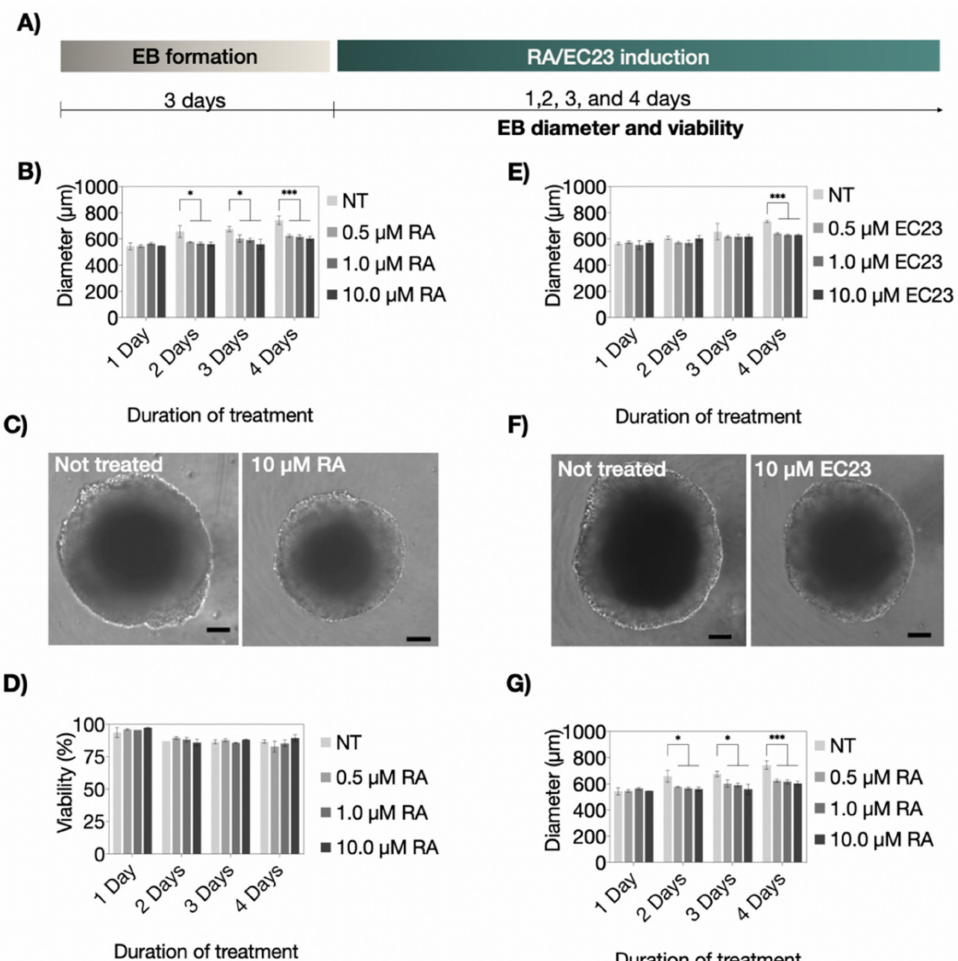
Figure 2. ( A ) Schematic workflow of neuronal and astrocytic differentiation protocols using retinoic acid (RA) or EC23 as inducers. Diameters of embryoid bodies after one-, two-, three- and four- day treatment with concentrations of non-treated (NT), 0.5 µ M, 1.0 µ M, and 10 µ M of ( B ) RA and ( E ) EC23. Bright-field micrographs of non-treated, ( C ) 10 µ M RA-treated, and ( F ) 10 µ M EC23-treated P19 embryoid bodies in a microtiter plate after four-day treatment. Scale bar, 100 µ m. Viability of embryoid bodies after one-, two-, three- and four days post-treatment with increasing concentrations of ( D ) RA and ( G ) EC23. Statistical significance was tested by using one-way ANOVA (* p < 0.05 and *** p < 0.001), n = 3 ± SD. Bars without * do not represent statistical